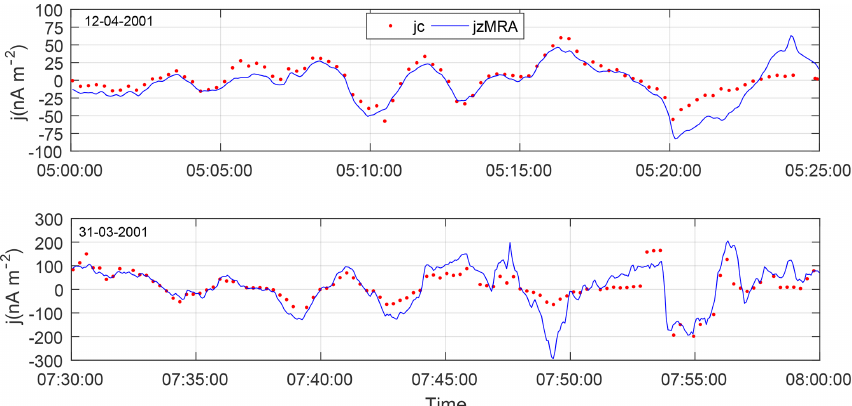
Figure 6. The z -component current density calculated from MRA method (the blue curve) and the estimated curvature current (the red dotted